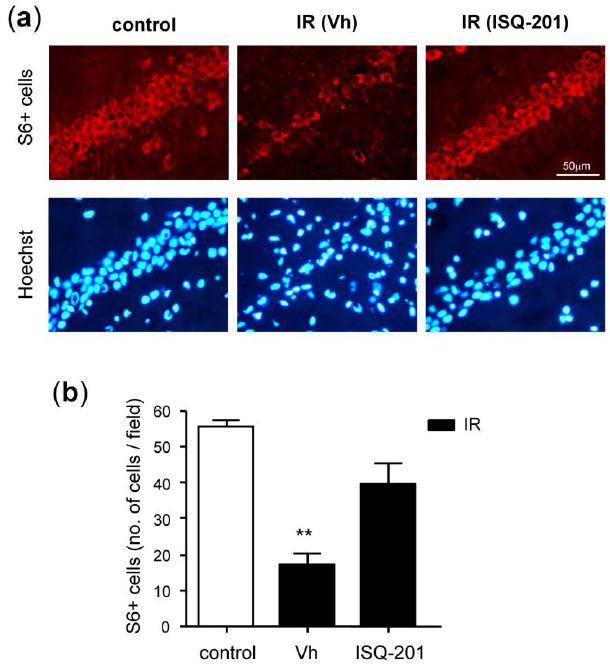
Figure 5. Long-term efficacy study of ISQ-201. ( a ) Brain sections from the sham control animals (control), or from vehicle (Vh)- and ISQ-201-treated (ISQ-201, 0.05 mg/kg) ischemic animals were evaluated for cell detection at 11 weeks after ischemic reperfusion (IR). IR animals were treated by an intravenous injection at the onset of reperfusion, after global cerebral ischemia. Neurons were labelled after fixation with an anti-protein S6 antibody and X red-secondary antibody, were visualized by fluorescence microscopy (in red), and the cells were also stained with the Hoechst dye (in blue). The images are representative results of the hippocampal CA1 region. ( b ) The bar graph represents the number of positive-cells for S6 labeling (S6+ cells), per field of the hippocampal CA1 region from the control animals and the vehicle (Vh)- and ISQ-201-treated ischemic reperfused animals. Values represent the mean of six independent animals, and the error bars indicate the SE, ** p < 0.01, compared to the control group, through Dunnett’s post-test, after ANOVA.